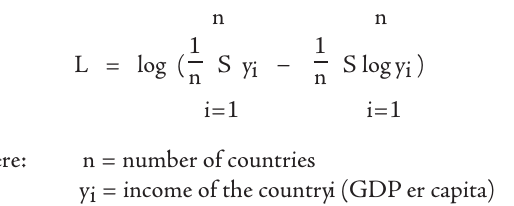
Table 1 – Summary of the analysis of the change in national income distribution in the 1970s, 1980s and early